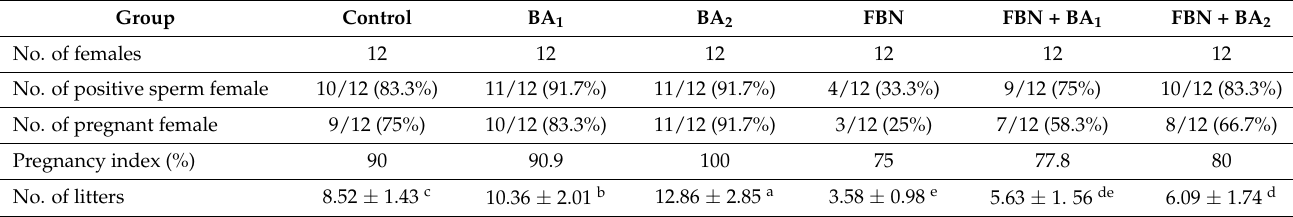
Table 2. The effect of fipronil (FPN) and co-treatment with boswellic acid (BA) on fertility index of rat.